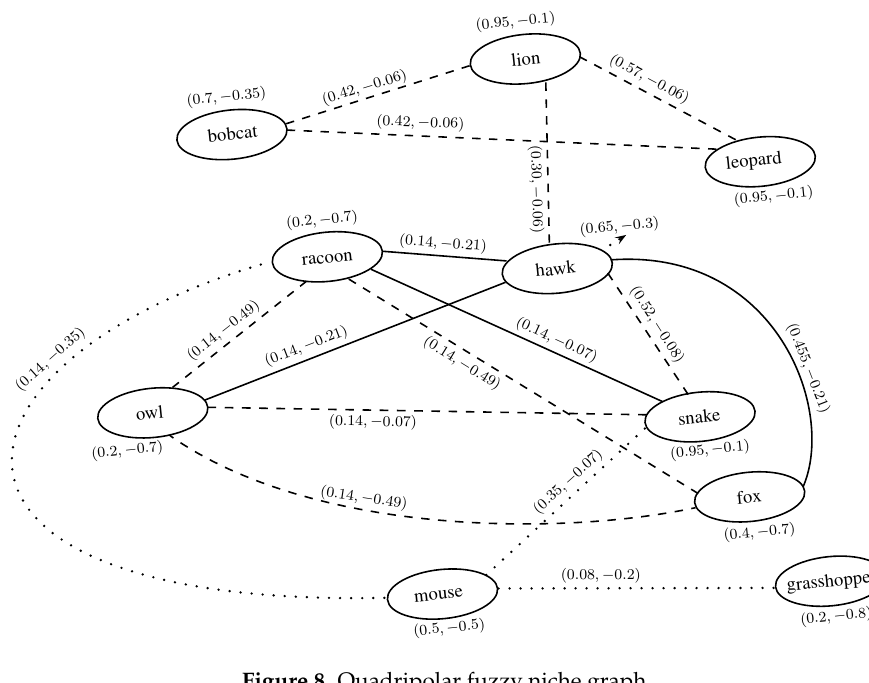
Figure 2.8: 4 polar fuzzy niche graph Figure 8. Quadripolar fuzzy niche graph.